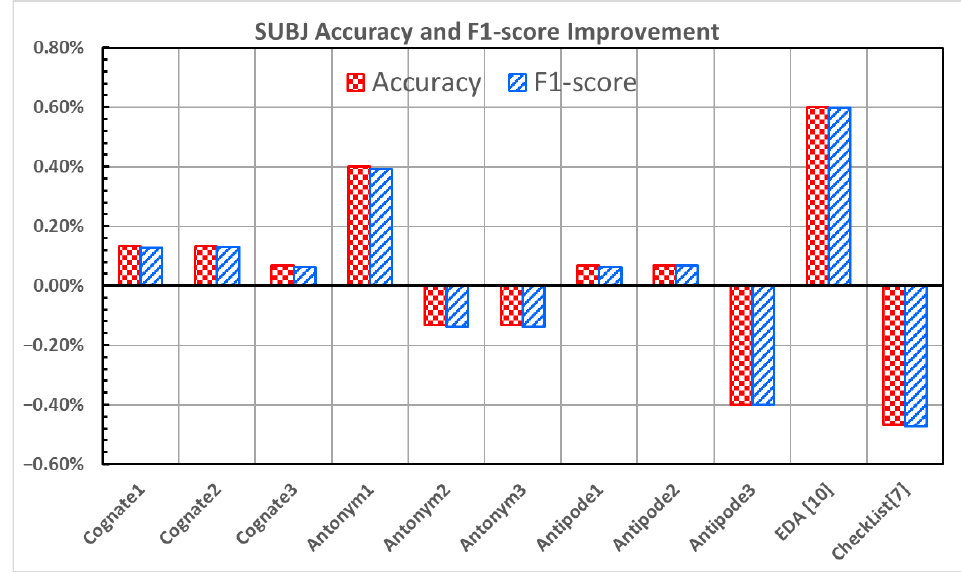
Figure 3. SUBJ Performance Improvement Results.